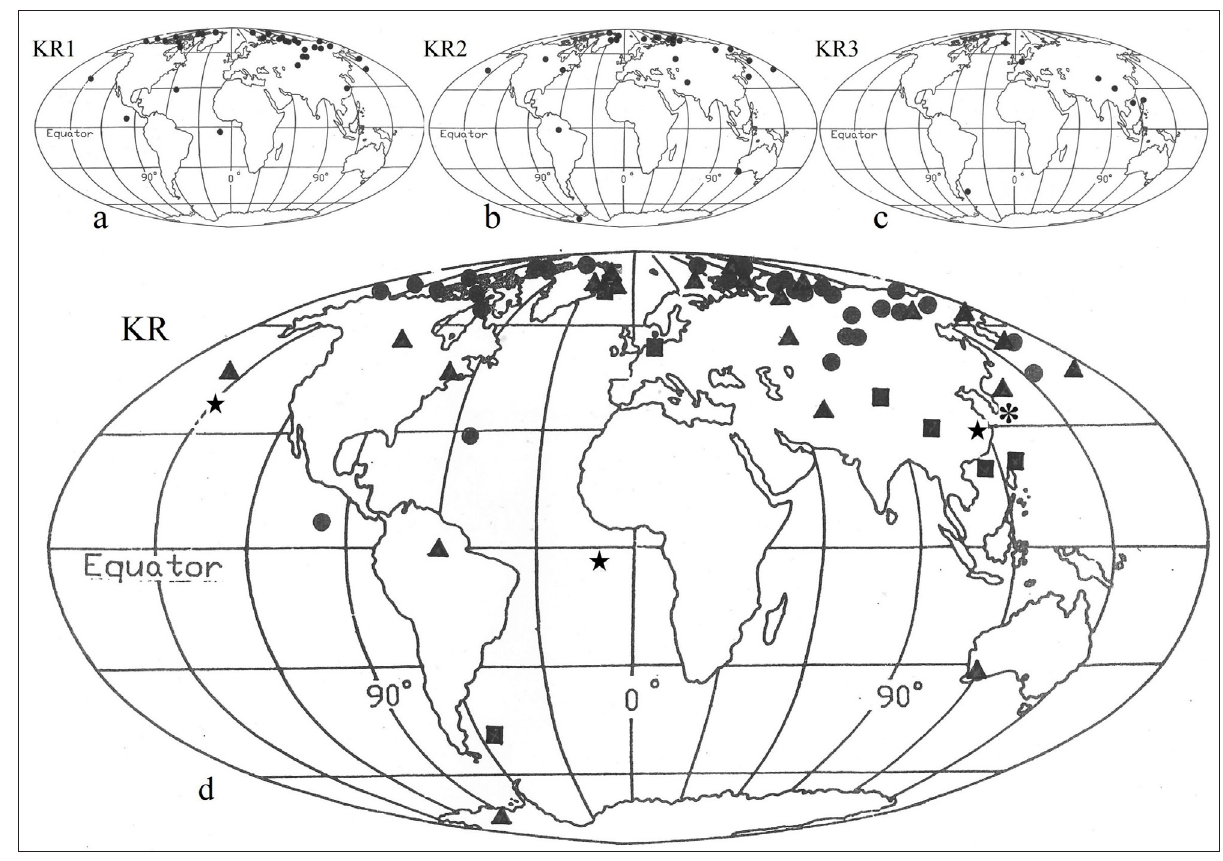
● , KR1; ▲ , KR2; ■ , KR3. The stars represent samples KR31 to 33 and the asterisk shows the VGPs calculated from the secondary direction of KR3 #5. Figure 8: Virtual geomagnetic pole (VGP) paths plotted on a world map for the sections mentioned in the text: (a) KR1, (b) KR2, (c) KR3 and (d) all VGPs from Klasies